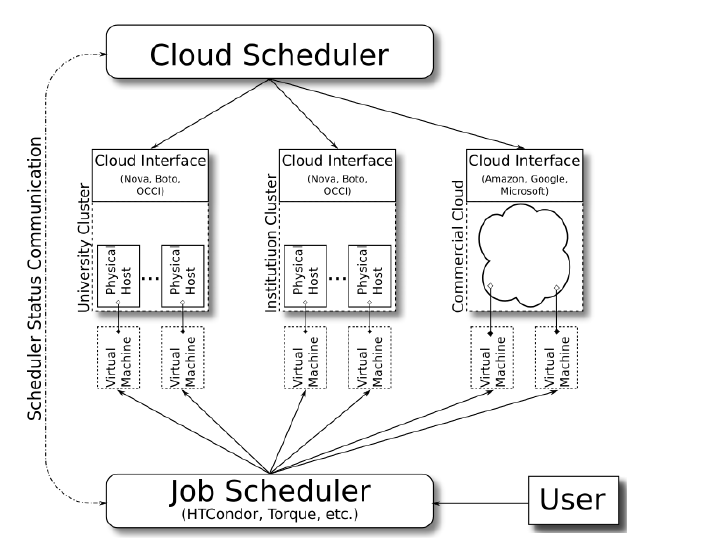
Figure 2: Cloudscheduler schema, Cloudscheduler [2] polls the job scheduler for job require- ments and starts / stops VMs on attached clouds when needed depending on those require-